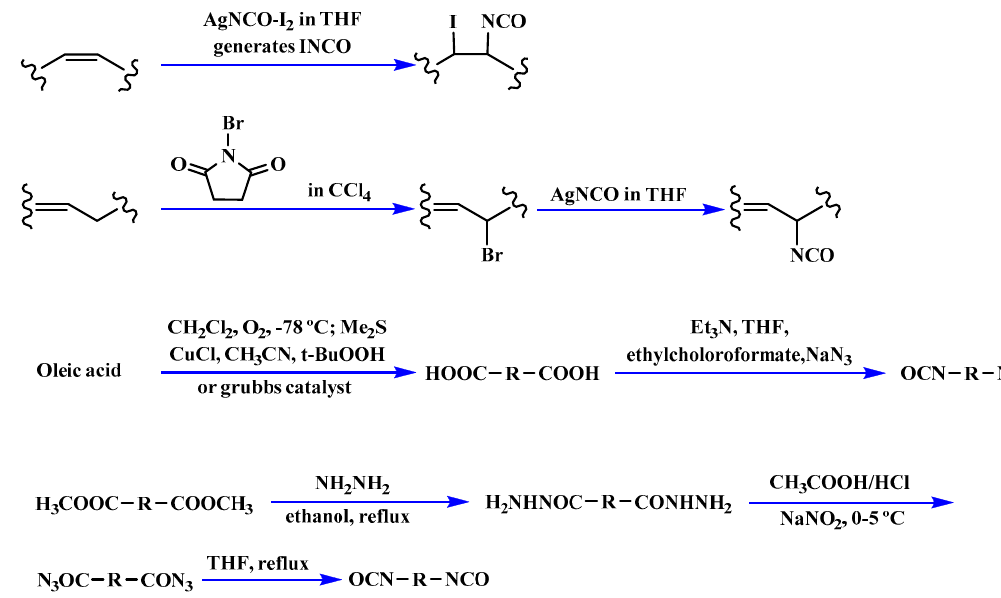
Figure 3. Synthesis of bio-based multi-isocyanate derived from vegetable oils [77].